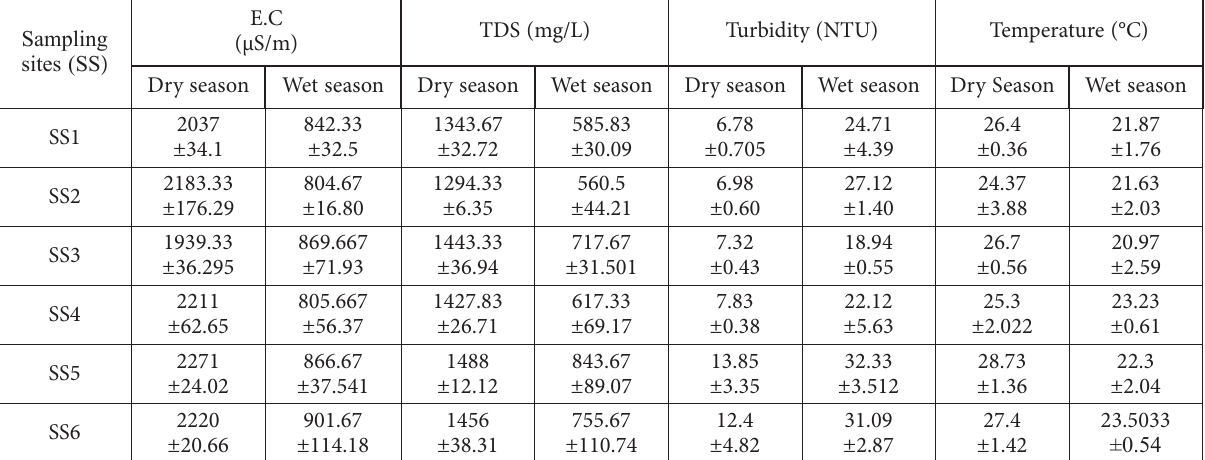
Table 1. Seasonal and temporal variation in physical quality parameters of groundwater Sampling sites (SS )